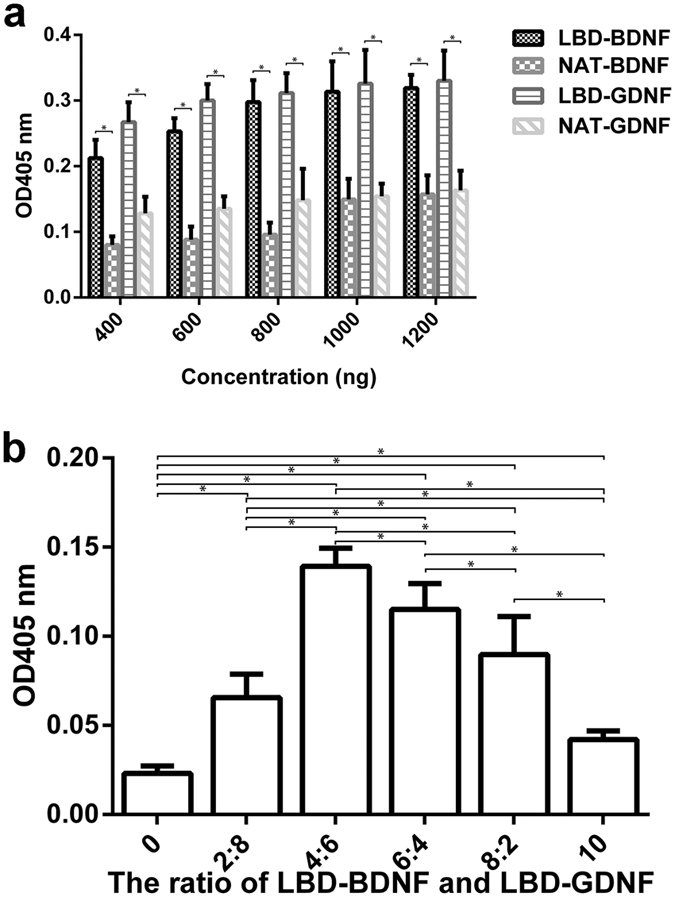
Effect of recombinant proteins on cell survival in PC 12 cells by CCK-8 assay.(a) More living cells were found in the neurotrophic factors with NtA, when the same quality recombinant proteins were provided. (b) More living cells were found in only LBD-GDNF added than only LBD-BDNF (P < 0.05). Whatever ratios of LBD-BDNF and LBD-GDNF mixed are preferable than single usage of LBD-BDNF or LBD-GDNF (P < 0.05), and the most living cells were found when the ratio of LBD-BDNF to LBD-GDNF was 2:3 (P < 0.05). The ratio of 0 or 10 indicates cells were cultured in the mentioned conditions without LBD-BDNF or LBD-GDNF. n = 6. *P < 0.05.